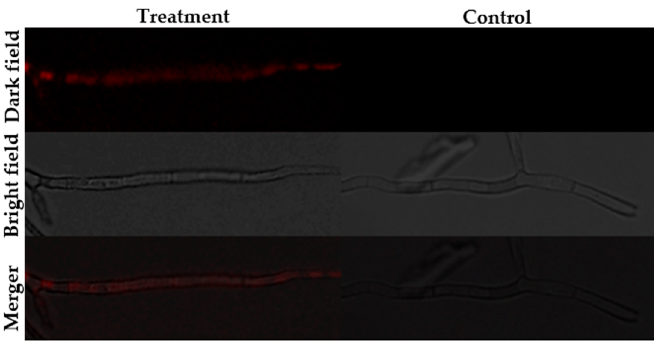
Figure 7. Decrease in mitochondrial membrane potential of Mycosphaerella arachidicola caused by BGAP.